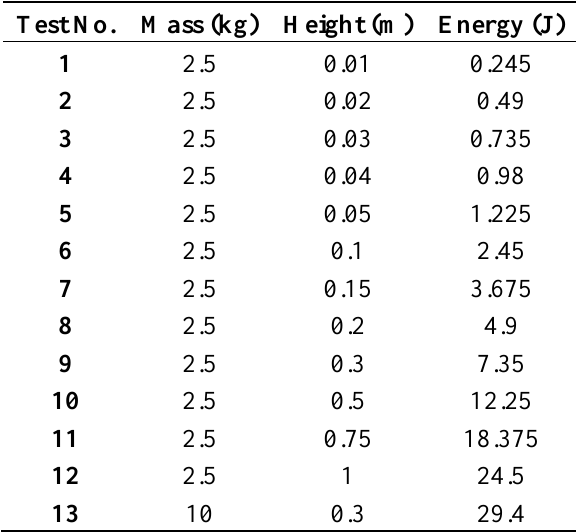
Table 2. Conditions applied to the performed